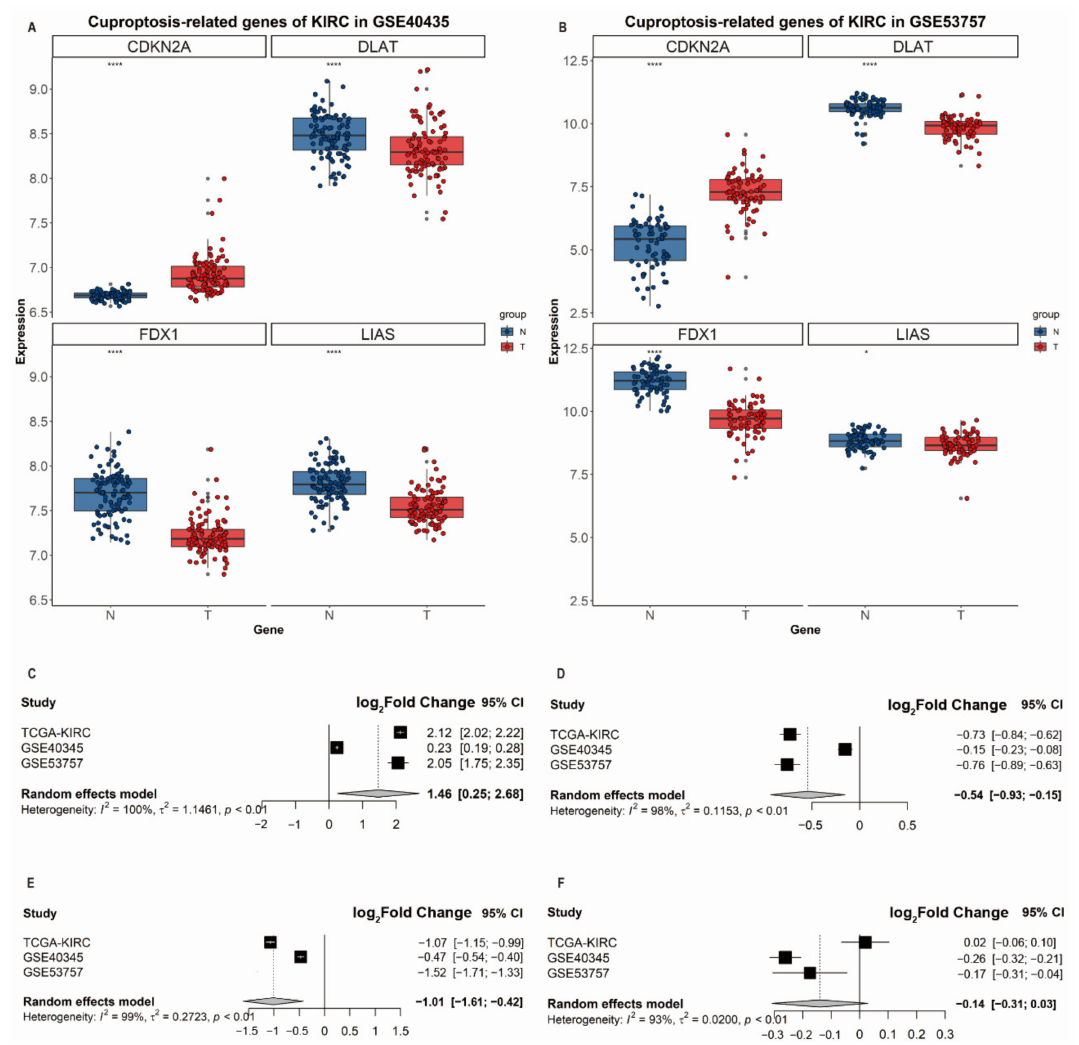
Figure 5. Differential expression analysis and validation in three datasets. Boxplots of the expression of CDKN2A , DLAT , FDX1 and LIAS in ( A ) GSE40435 and ( B ) GSE53757. Forest plots of the meta- analysis of the differential expression of ( C ) CDKN2A , ( D ) DLAT , ( E ) FDX1 and ( F ) LIAS in GSE40435, GSE53757 and